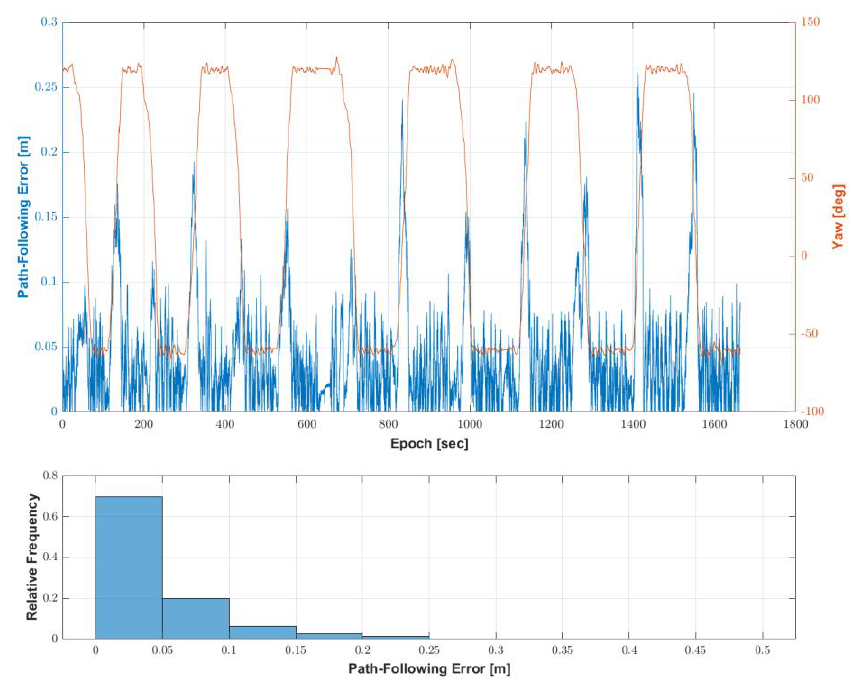
Figure 11. The path-following error during the first test of the autonomous driving-based spraying test.